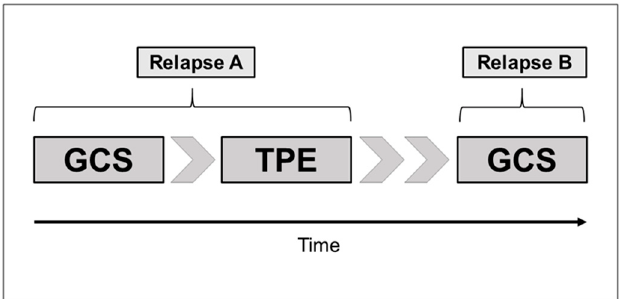
Figure 4. Treatment algorithm of 37 clinically isolated syndrome (CIS) and multiple sclerosis (MS) patients. Relapse A represented the initial, glucocorticosteroid (GCS)-unresponsive relapse treated with GCS and subsequent therapeutic plasma exchange (TPE); Relapse B represented the first acute relapse after TPE treated with GCS again.